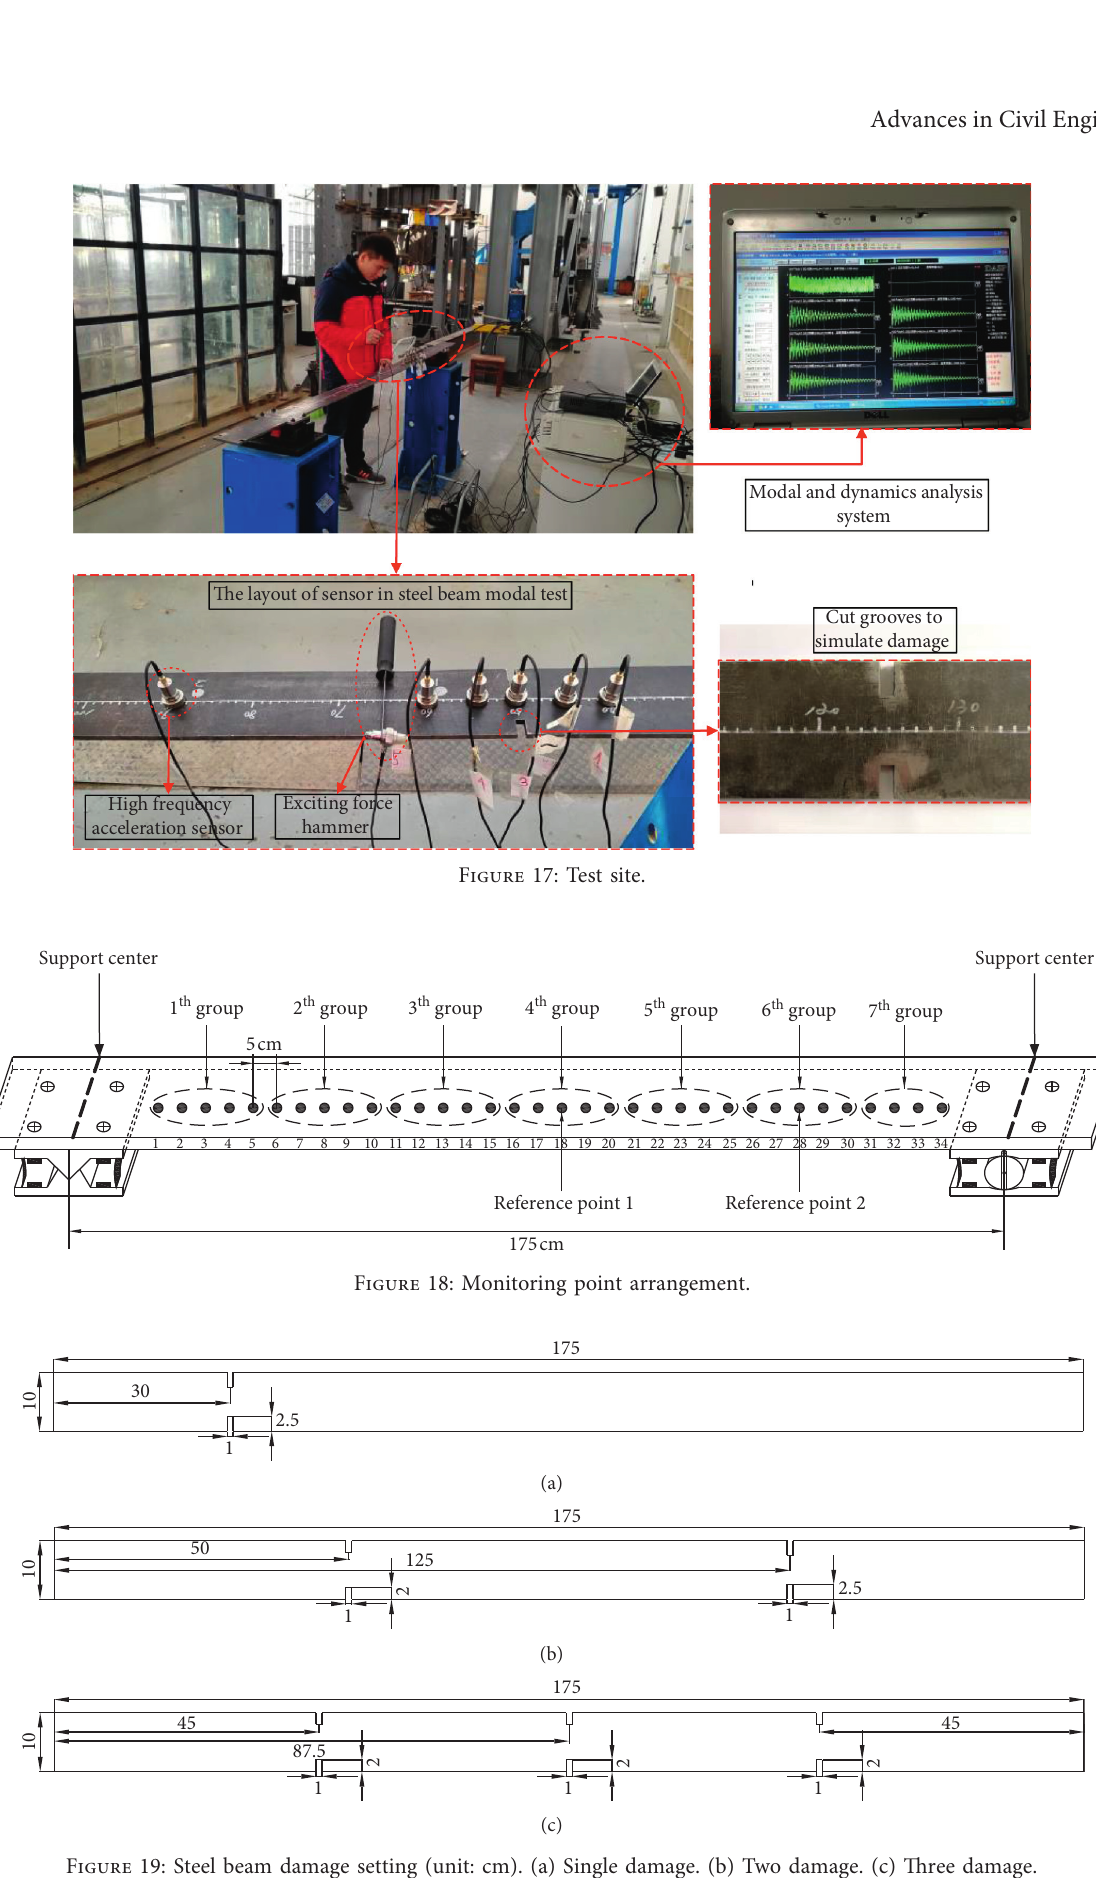
Figure 19: Steel beam damage setting (unit: cm). (a) Single damage. (b) Two damage. (c) Three